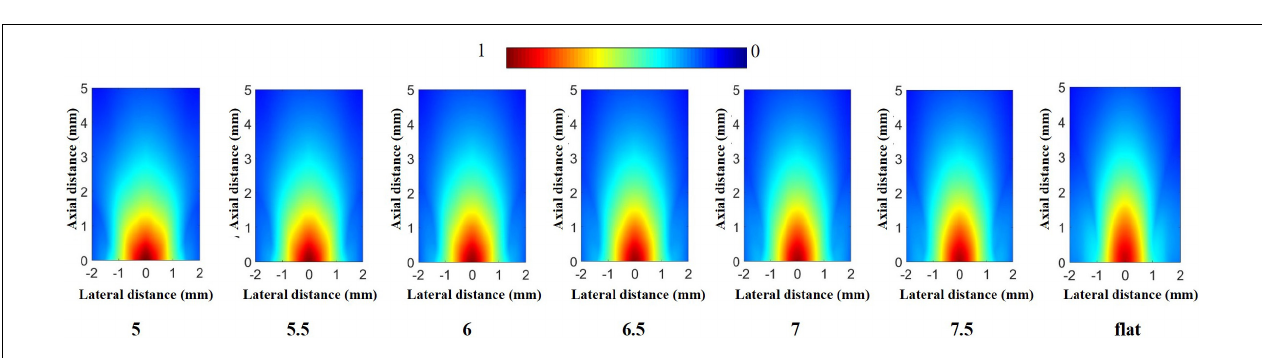
FIGURE 5 | Emission acoustic field in the